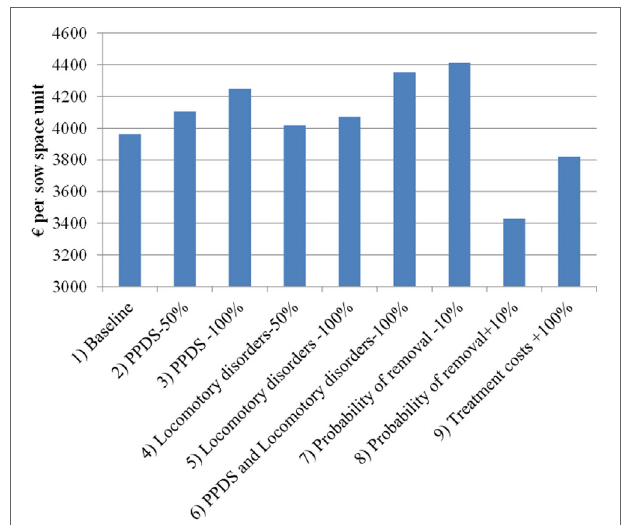
FigUre 4 | Return on fixed costs (€ per sow space unit) in the scenarios simulated by the dynamic programming model. PPDS, postpartum dysgalactia